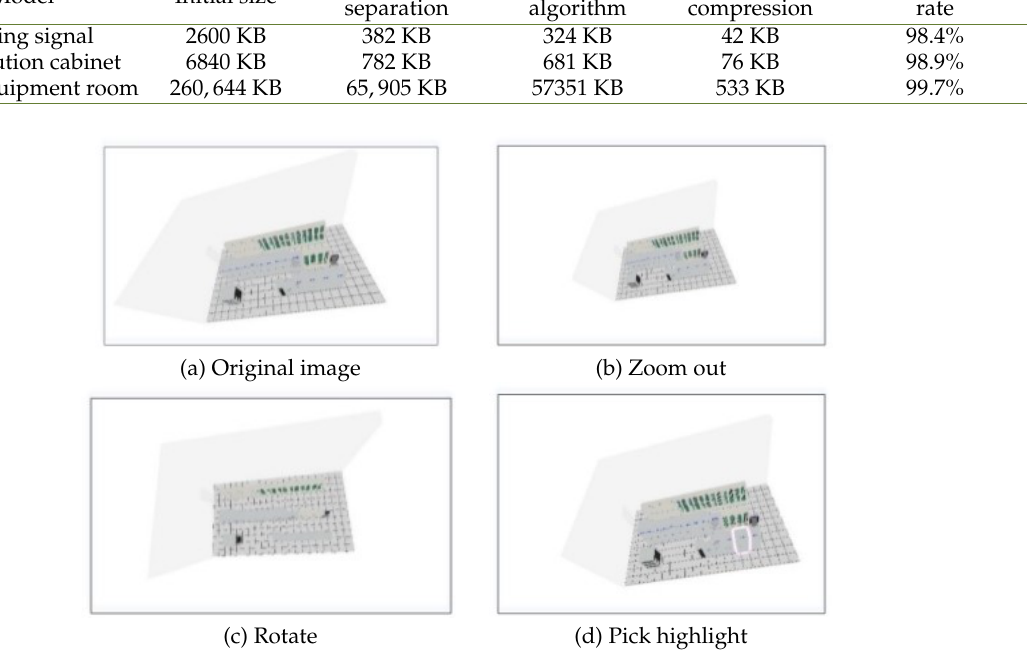
Fig. 11. Schematic diagram of model interaction